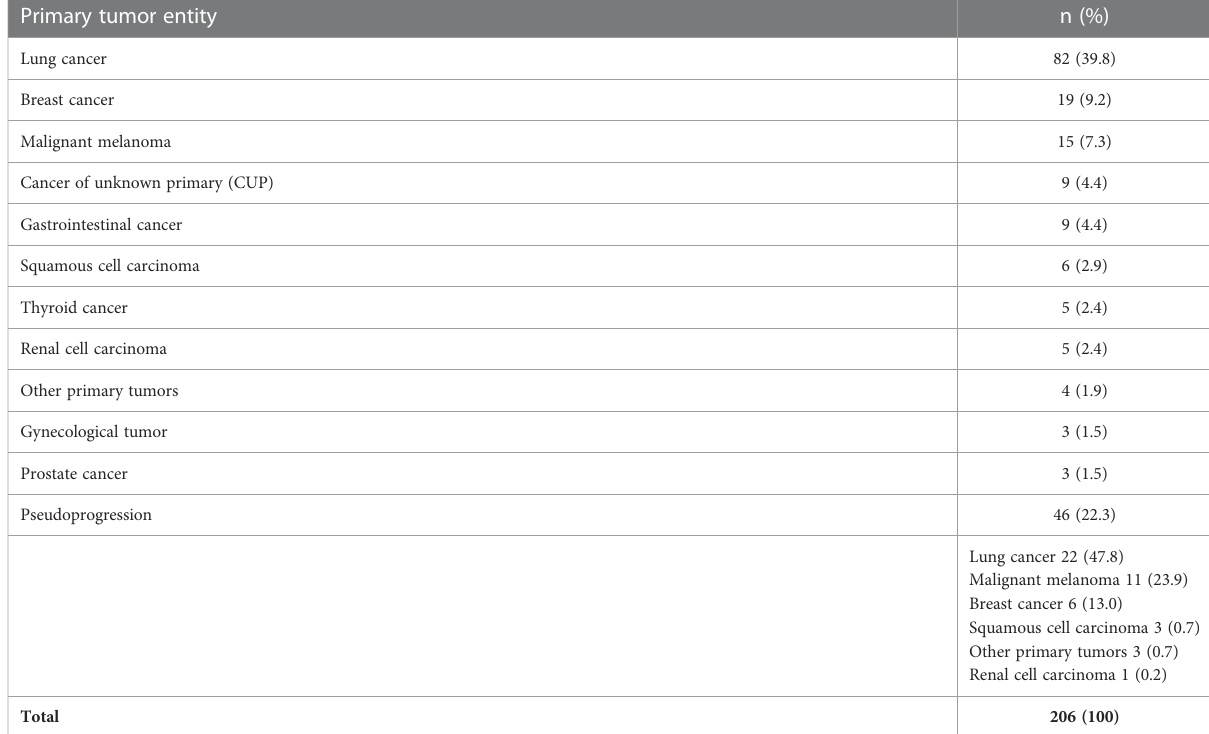
TABLE 2 Listing of systemic tumor